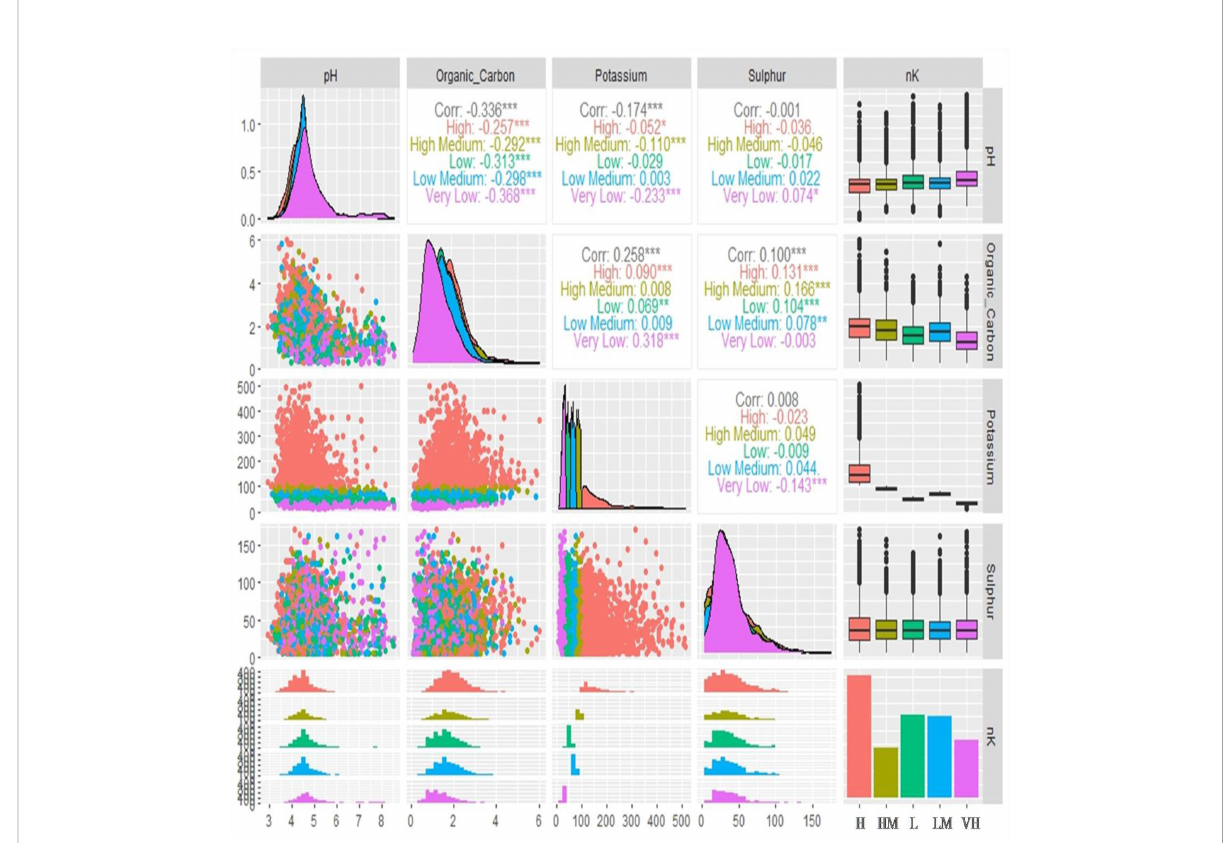
FIGURE 6 Bivariate correlations of reported soil parameters (pH, organic carbon, available potassium, and available sulphur) of 7300 analyzed soil samples against different categories of soil available potassium (AK) represented by box plot, density, scatter, histogram and bar diagram (in bar diagram H, High; HM, High Medium; L, Low; LM, Low medium and VL, Very low; here ‘ Organic_Carbon ’ is ‘ OC ’ , Potassium is ‘ available potassium (K) as